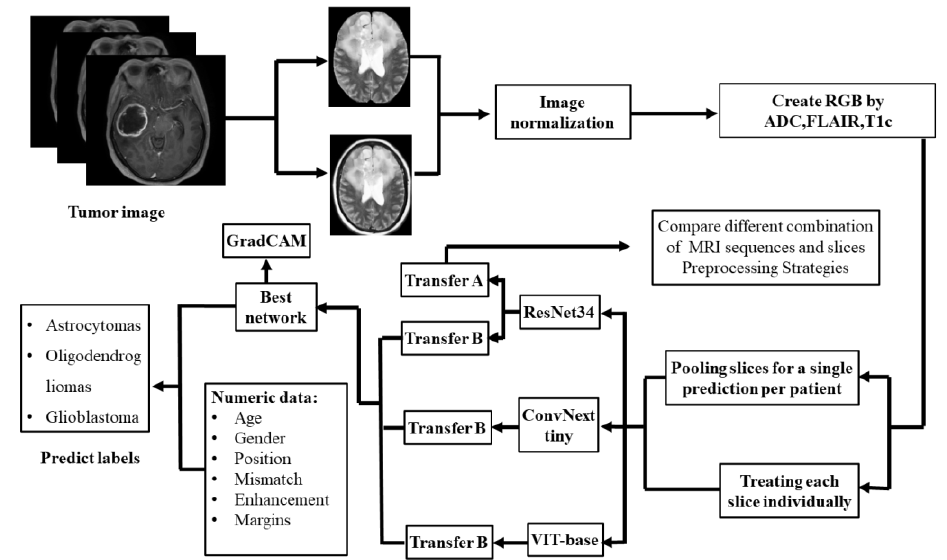
Figure 5. The flowchart of the entire process. All images were first normalized. Secondly, ADC, FLAIR, and T1c were used to create RGB. Thirdly, we used the second strategy of transfer learning to compare three frameworks and select the best one. The best model was used in combination with numerical data to get the final prediction. ResNet34 with the first strategy of transfer learning was used to compare the different MRI sequence and slicer preprocessing strategies.